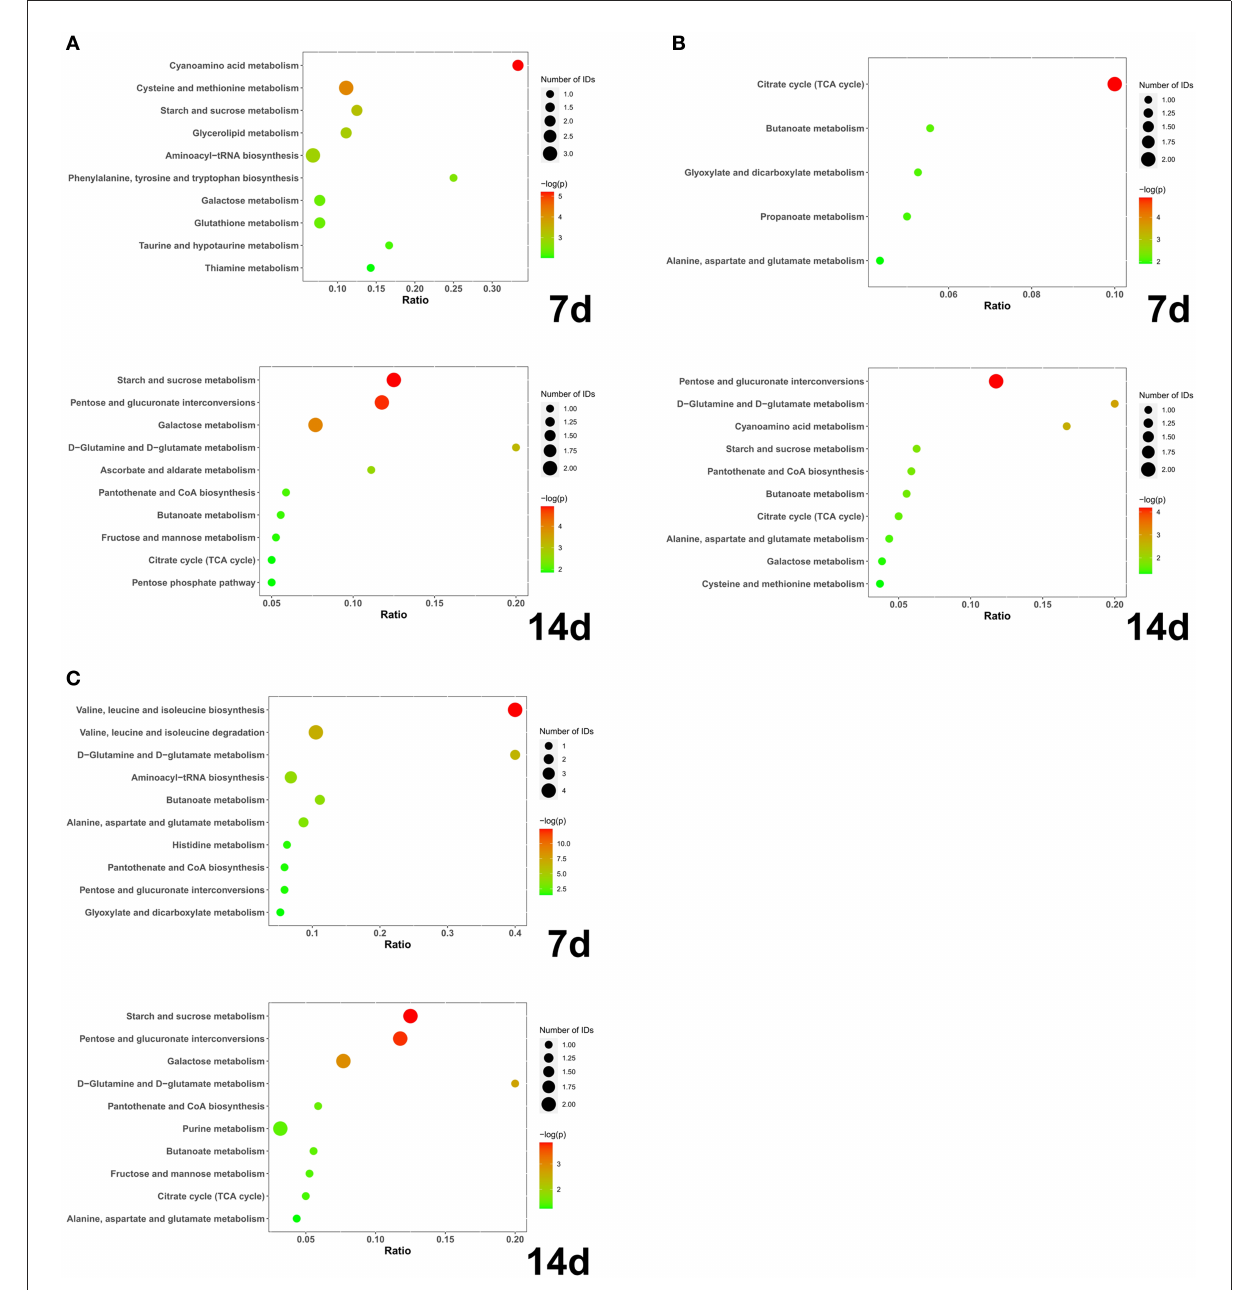
FIGURE4 (A) IS-C; (B) EE-IS; (C) APS-IS. The abscissa axis Ratio represents the ratio of differential metabolites enriched to this metabolic pathway to total metabolites; the size of bubbles represents the number of differential metabolites enriched to this metabolic pathway; the larger the -log( P ), the smaller the P -value and the more significant the difference ( N =